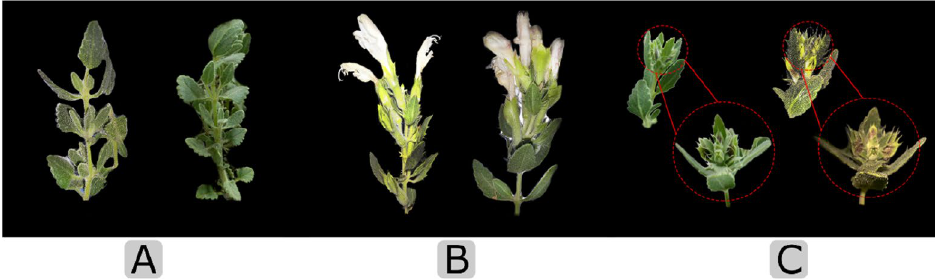
Figure 5. The tissue samples of D. kotschyi, which were used for RNA extraction and qRT-PCR analysis, include flowering leaves ( A ), flowers ( B ), and buds ( C